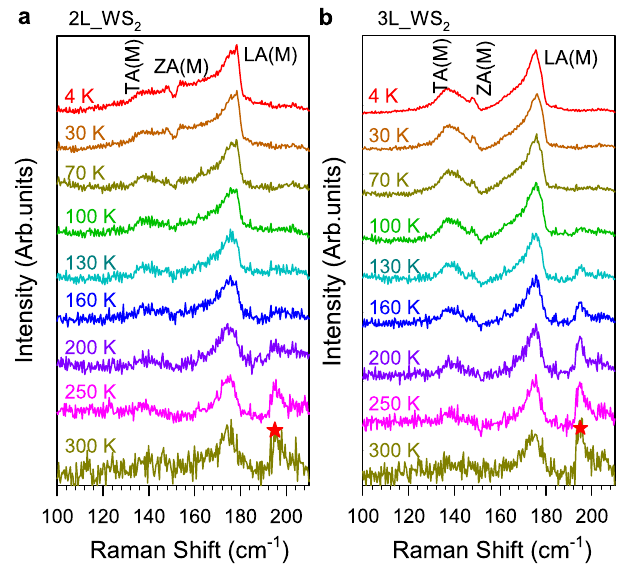
Fig. 4 | Temperature dependence of quantum interference. a, b Temperature- dependentRamanspectraofTA(M)andZA(M)andLA(M)phononmodesin2Land 3L WS 2 with 612 nm excitation. The intensities are normalized to the LA(M) mode. The starsymbolindicates the second-order phonon mode:E 0 (M) - LA(M).The data are offset for